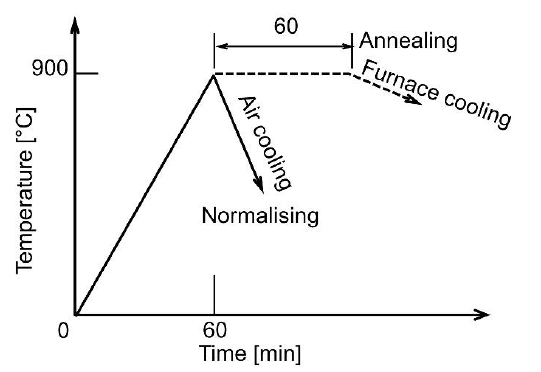
Figure 7. Heating path used for the heat treatment. J. Manuf. Mater. Process. 2020 , 4 , x FOR PEER REVIEW